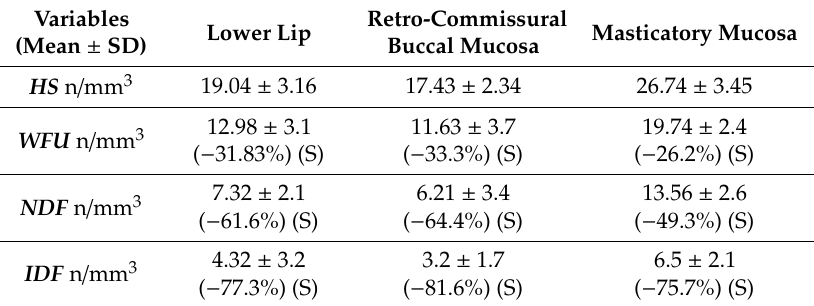
Figure 5. Capillaroscopic “sun” pattern in NDF patients. Table 2. Capillary density (% di ff erences with HS).